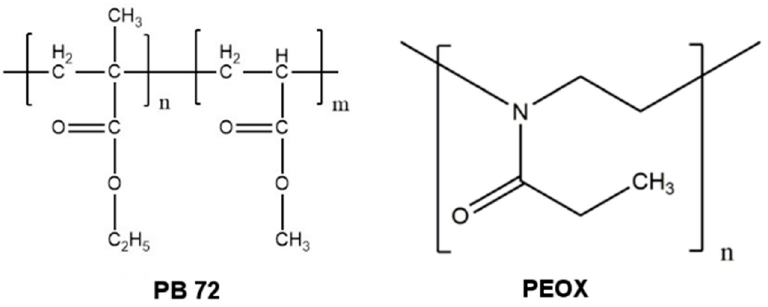
Figure 1. The molecular structure of Paraloid B72 (PB 72) and poly(2-ethyl-2-oxazoline) (PEOX), respectively.